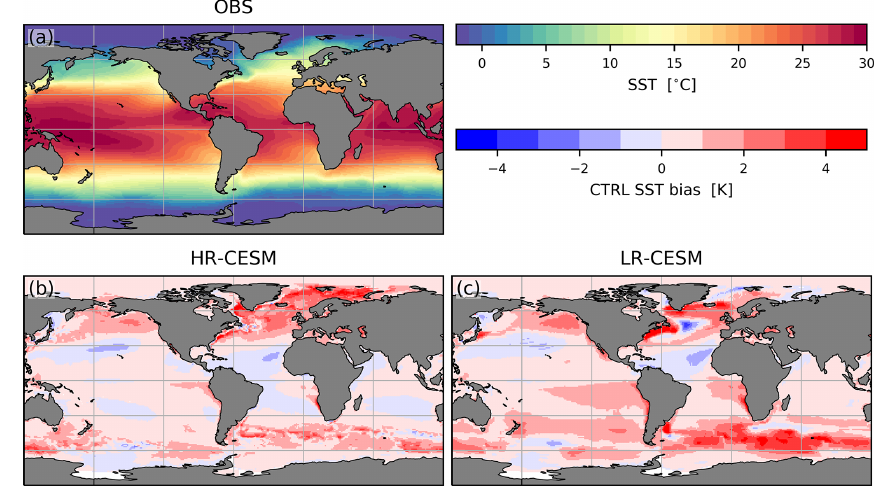
Figure A1. Bias of annual SSTs of the HR-CESM (a, b) and LR-CESM (c) CTRL simulations, like Fig. 1.